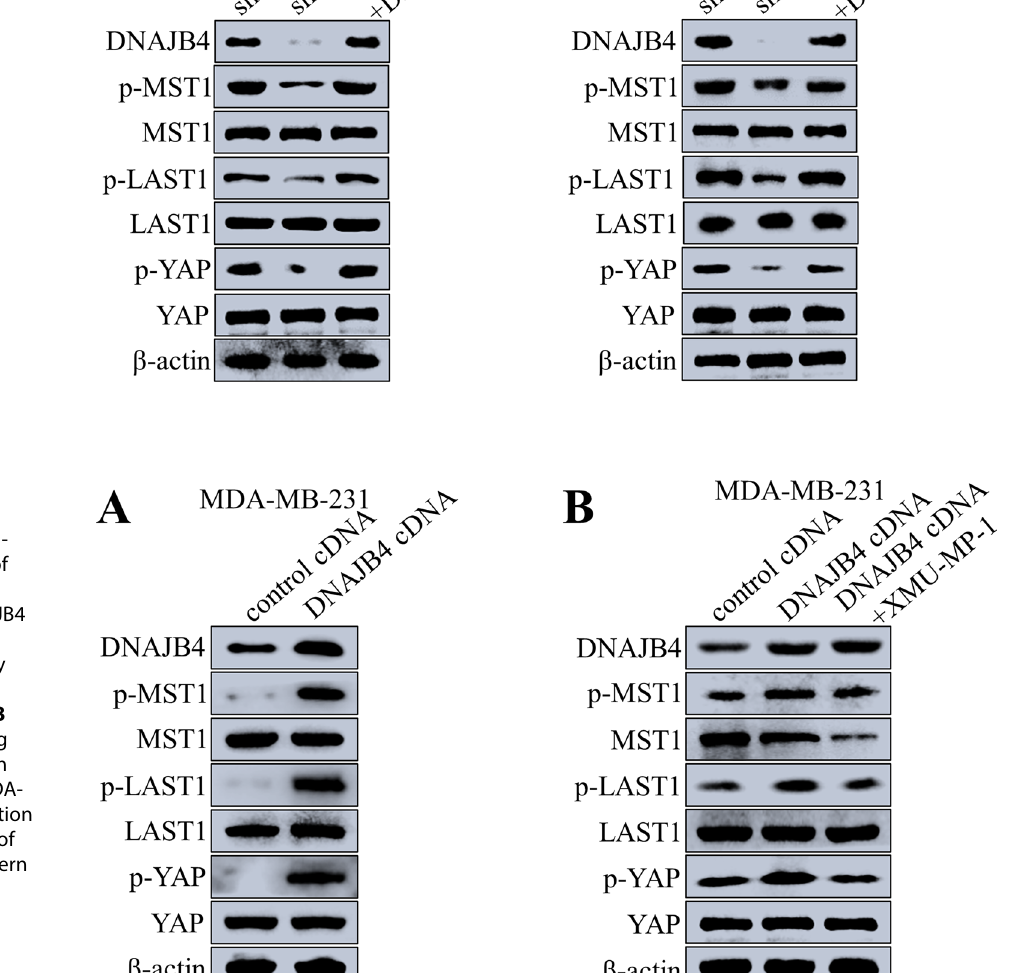
Fig. 5 DNAJB4 knockdown attenuates TNBC cell apopto- sis through suppression of the Hippo signaling pathway. A , B Changes of Hippo signal- ing pathway-related proteins after DNAJB4 knockdown in MDA-MB-231 and BT-549 cell, determined by western blot. β-actin was used as a loading control. C , D Changes of Hippo signaling pathway- related proteins in DNAJB4 knockdown MDA-MB-231 and BT-549 cells after the addition of cDNA lentivirus overex- pressing DNAJB4, determined by western blot. β-actin was used as a loading control